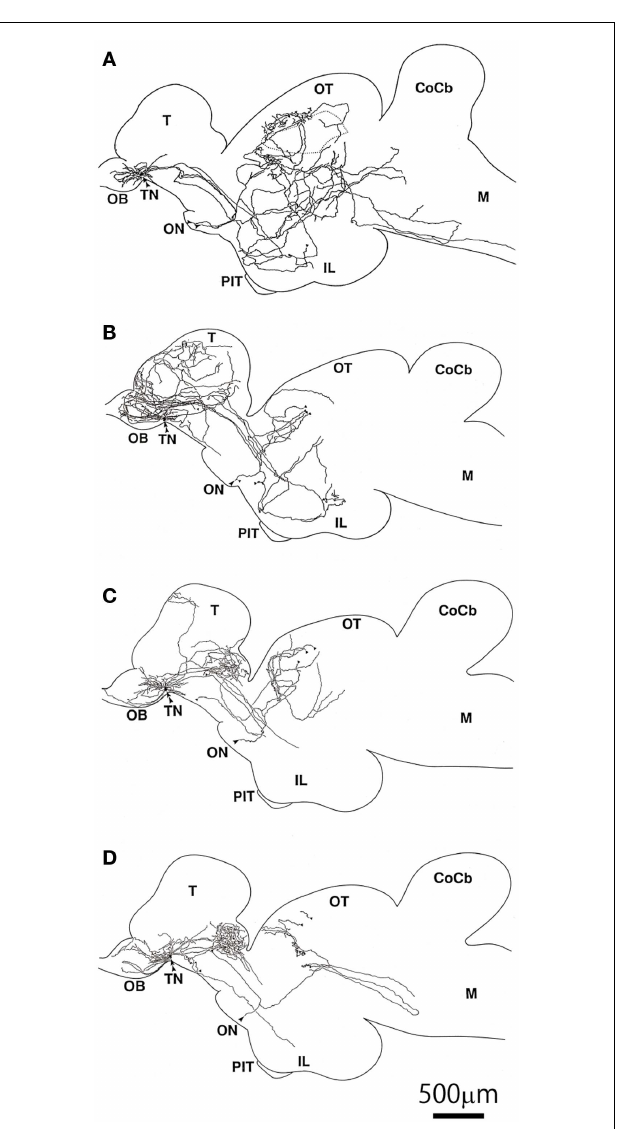
FIGURE 5 | Illustrations of intracellularly labeledTN-GnRH3 neurons reconstructed from serial sagittal sections . (A–D) The double arrowheads indicate the cell bodies.The same scale bar applies to all illustrations